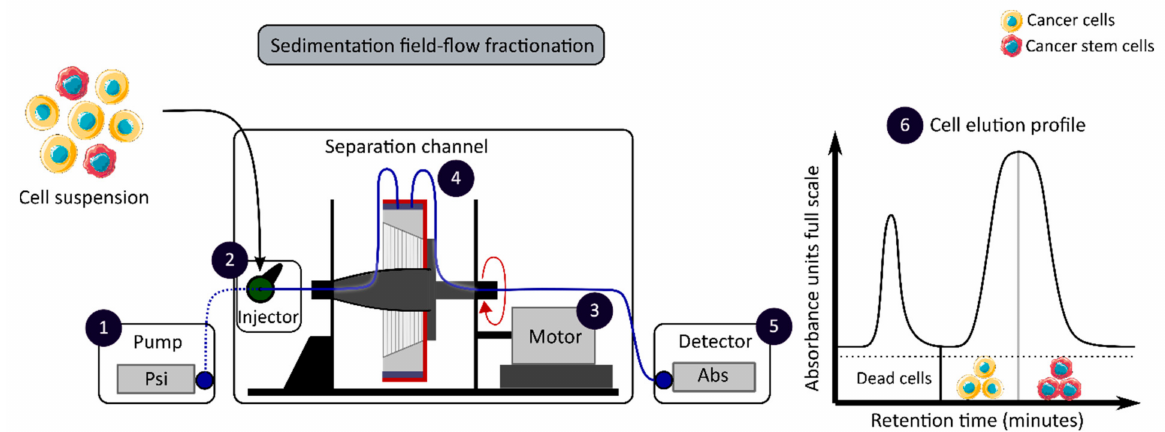
Figure 3. Biophysical sorting of CSCs according to their size, density, shape and rigidity using the SdFFF technique, which does not require cell labelling or fixation. The SdFFF is composed of a pump (1) to transport the mobile phase (PBS) and the cells, an injector (2) to introduce the cell suspension, a motor (3) to rotate the separation channel (4) and a detector (5) coupled to a computer to obtain the elution profile of the cell suspension (6). Psi is a common unit of pressure. CSC: cancer stem cell; SdFFF: sedimentation field-flow fractionation; PBS: phosphate-buffered saline; Abs: